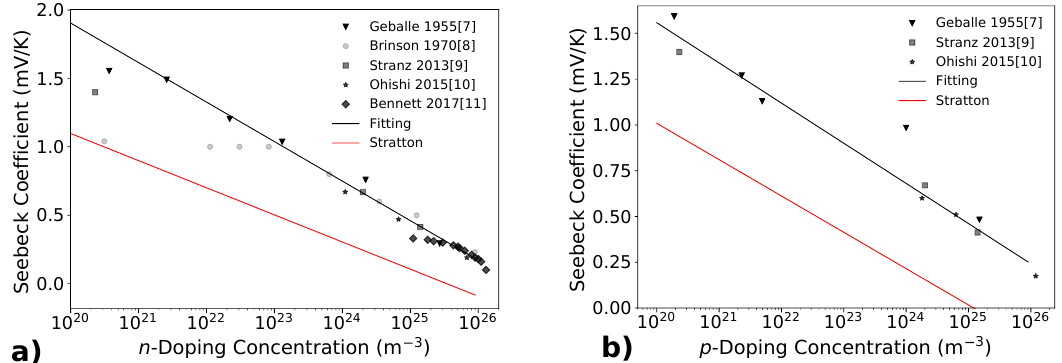
Figure 1. Available experimental data of the Seebeck coefficient are reported both for n -doping (Panel ( a )) and for p -doping (Panel ( b )). The logarithmic fit (see text) is also shown. The red lines show the Seebeck coefficient calculated with the Stratton formula (both for n and for p doping): experimental measurement give higher values of the Seebeck coefficient. Panel ( a ) is a modification of the figure published on